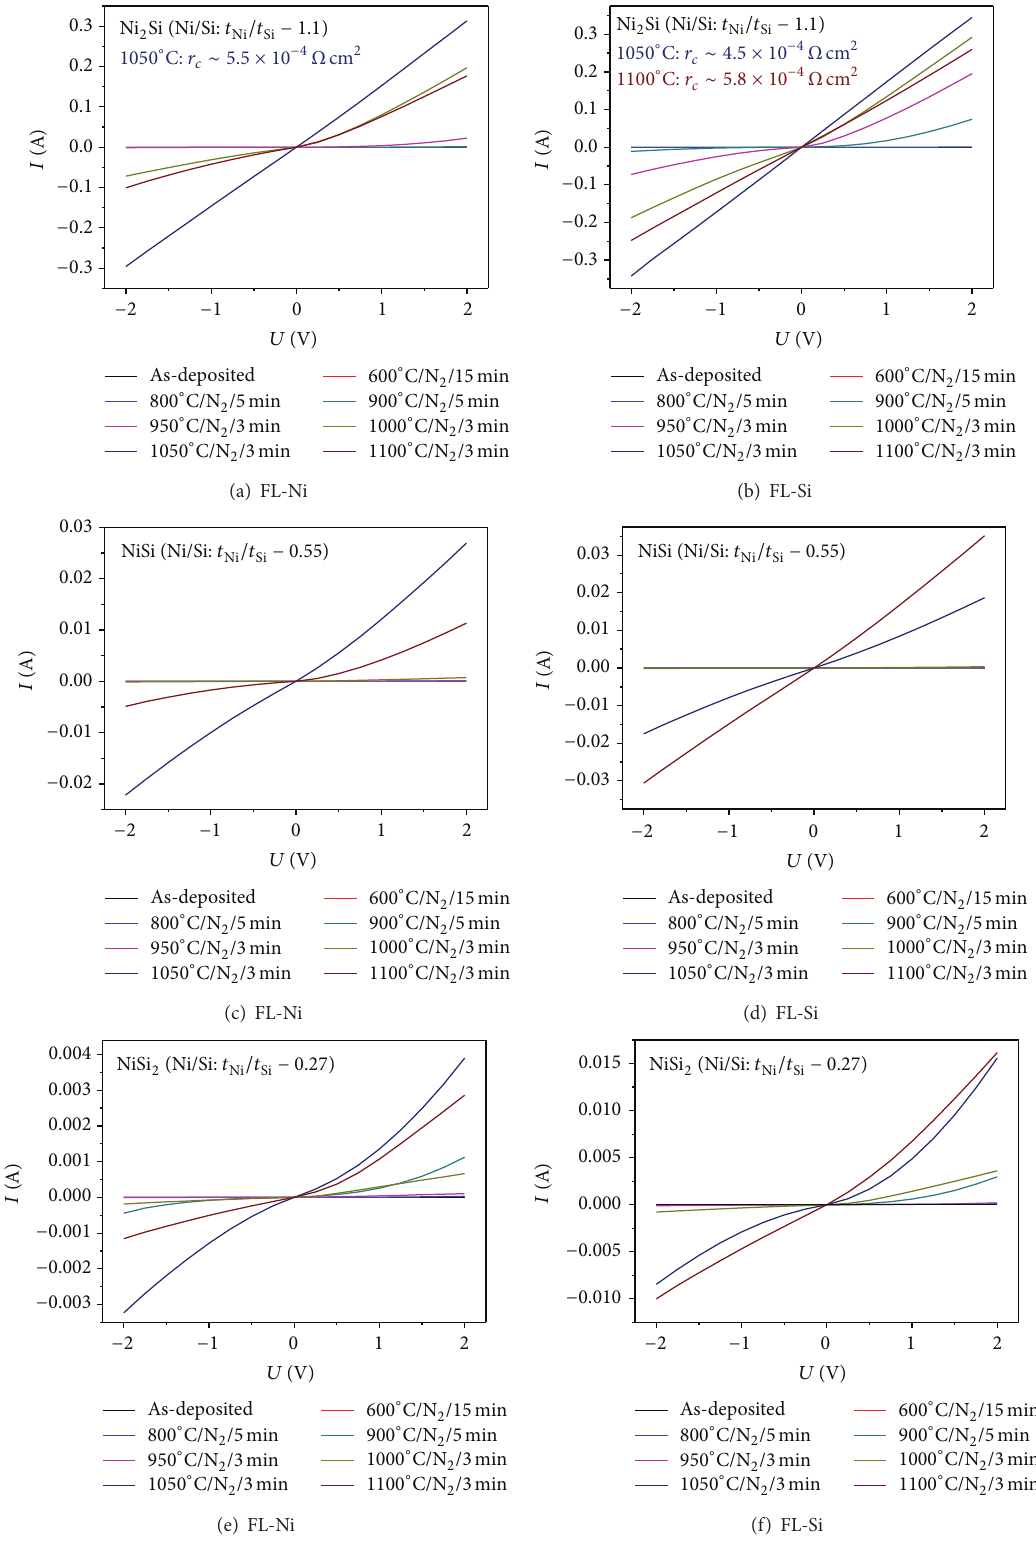
Figure 2: Electrical properties of Ni/Si multilayer contacts with different interfacial layer (Si: FL-Si or Ni: FL-Ni) and thickness ratio ( 𝑡 Ni /𝑡 Si ) to n -type ( ∼ 2 × 10 17 cm −3 ) 4H-SiC bulk wafers versus annealing